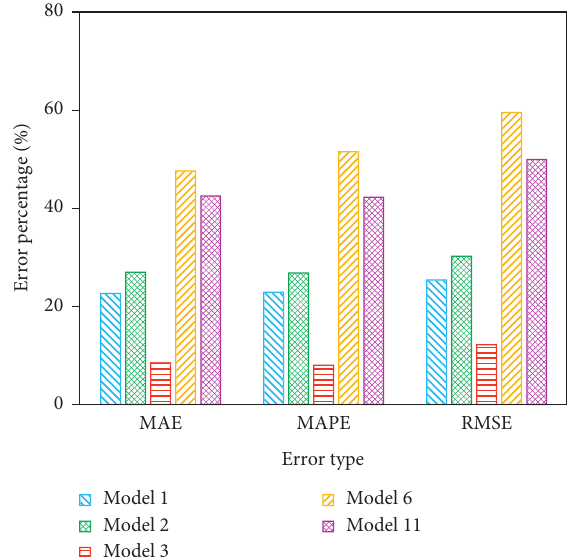
Figure 2: Multiple regression prediction error comparisons.